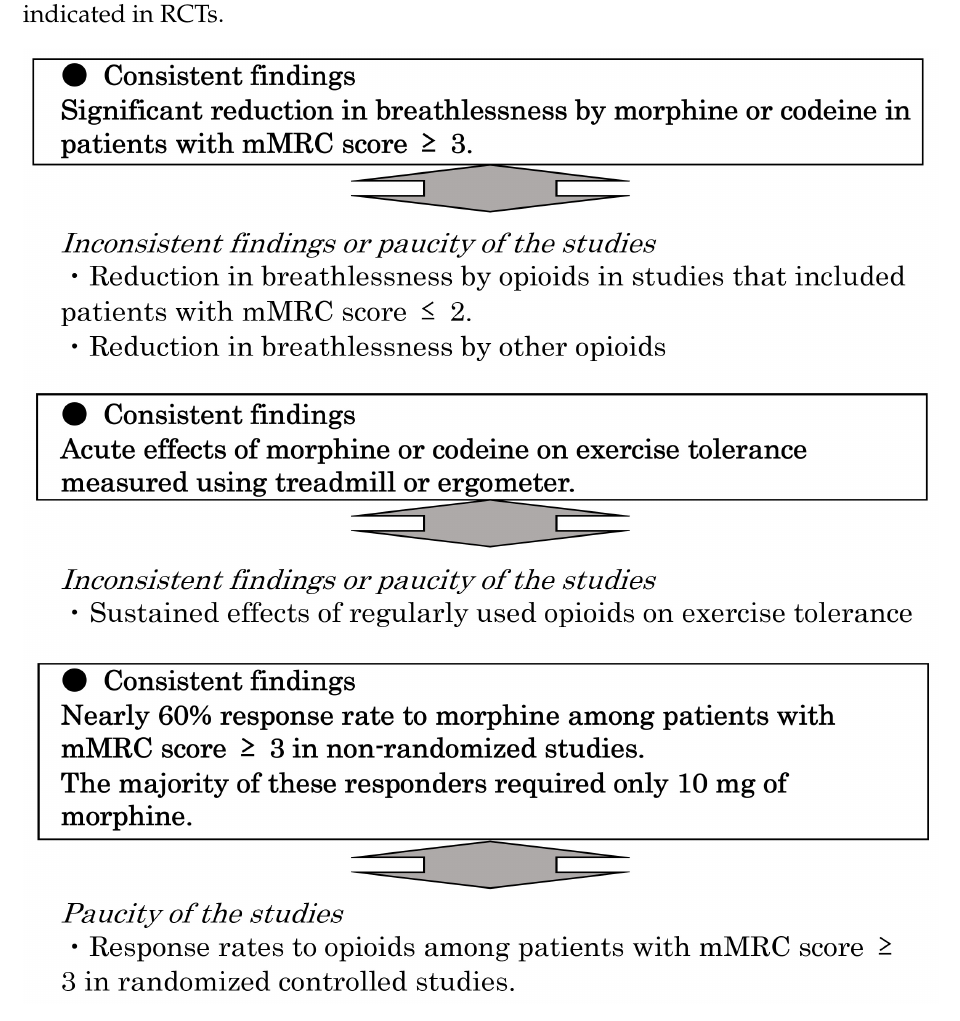
Figure 2. Consistent findings among heterogeneous studies of opioids for breathlessness due to non-cancer chronic respiratory diseases. mMRC, modified Medical Research Council.